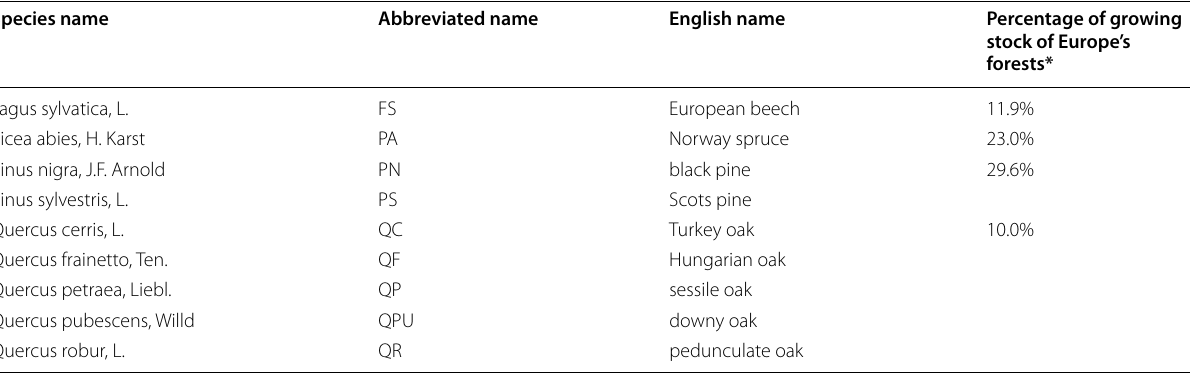
*According to the report on the State of Europe’s forests 2020. Data in this column refers only to the genus. Species-wide data was not